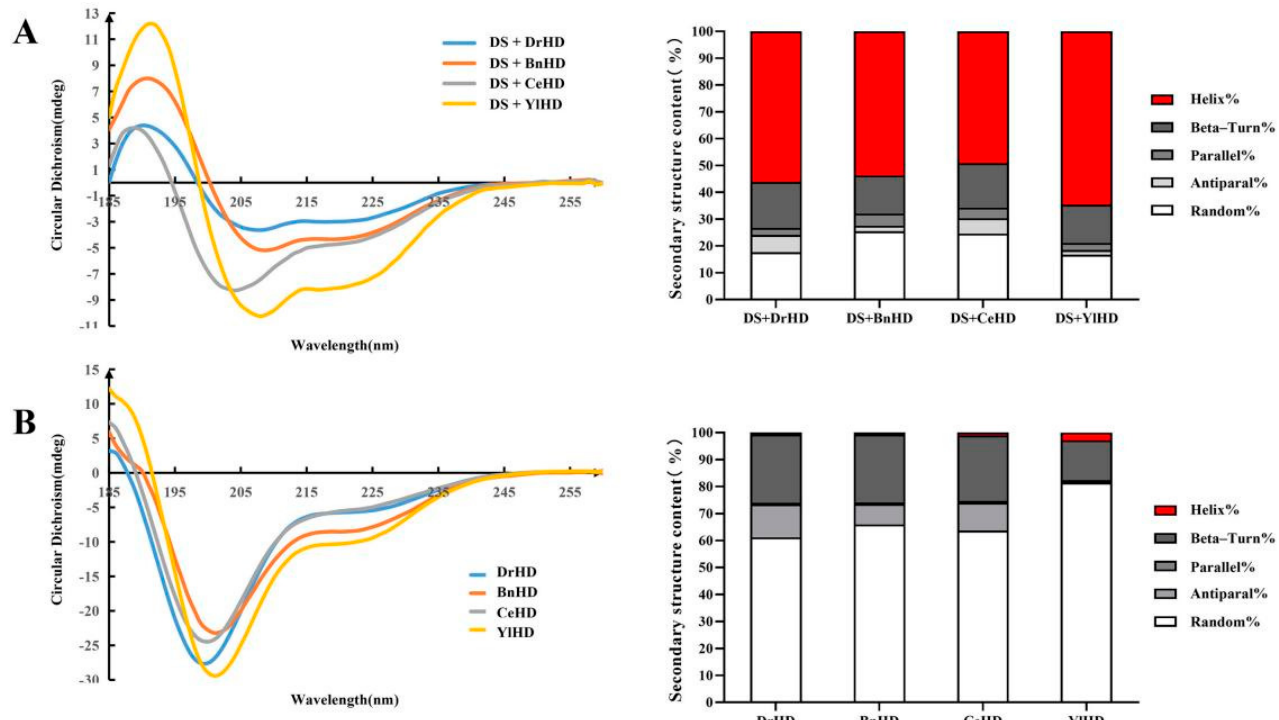
Figure 1. CD analysis of hydrophilic proteins. ( A ) The secondary structure of four non-natural hydrophilic proteins ( B ) and hydrophilic domain proteins in phosphate buffer. Percentages of a random coil (white), beta-Turn (dark grey), parallel (grey), antiparallel (light grey), and α -helix (red) are deduced from CD spectra using the CDNN program.